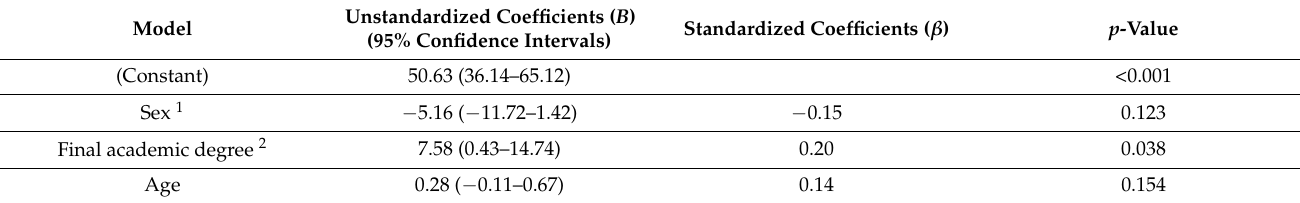
Table 3. Results of multiple regression modeling for the Rasch score of the seven-item Self-Reported Adherence to Patient-Centered Physical Therapy